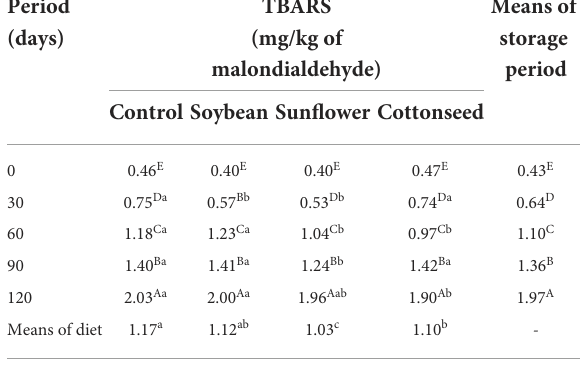
TABLE 6 Effect of storage period on 2–thiobarbituric acid reactive substance (TBARS, mg/kg of malondialdehyde) in burgers produced by meat of steers fed with different oilseeds sources, and interactions between factors. Period TBARS Means of (days) (mg/kg of storage malondialdehyde)